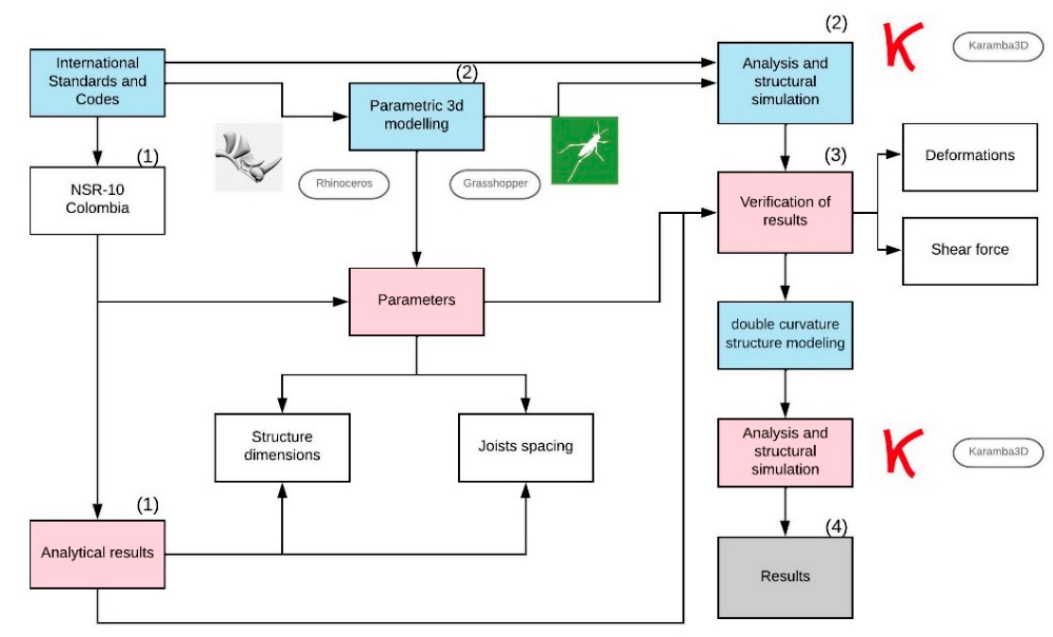
Figure 1. Workflow used for data verification.